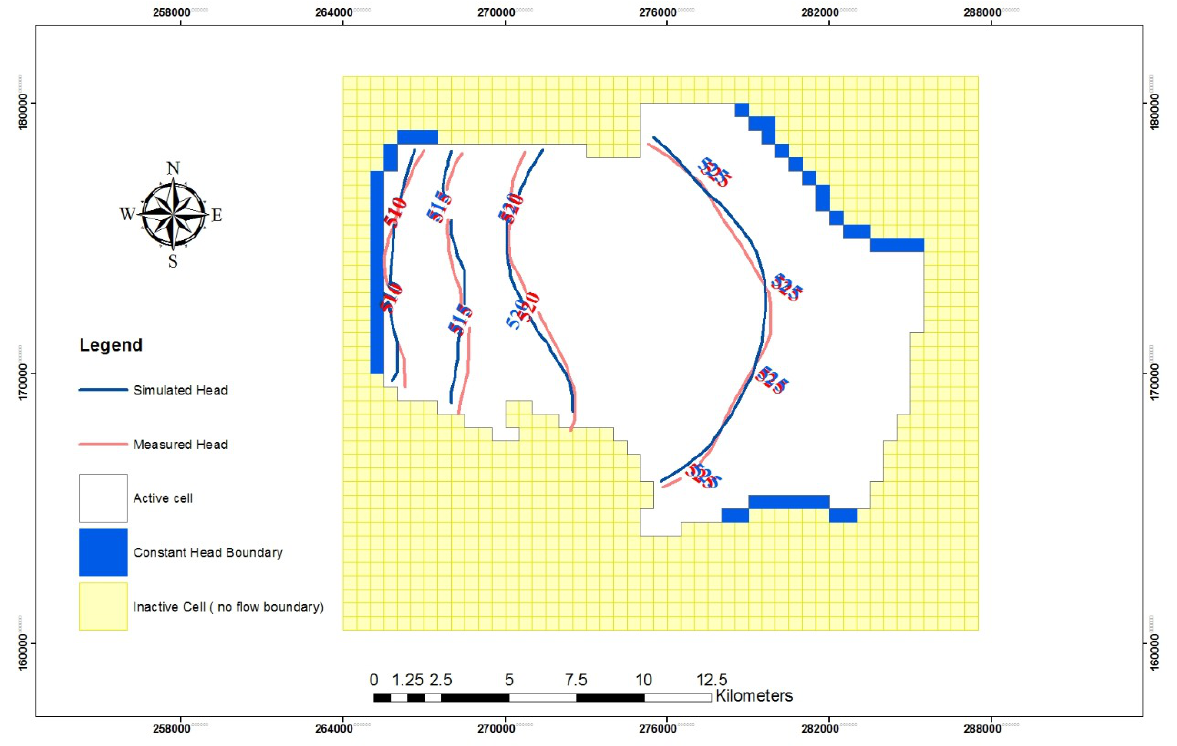
Figure 7. Map of the observed and simulated water levels for the B-B2/A7 formation (steady-state calibration).